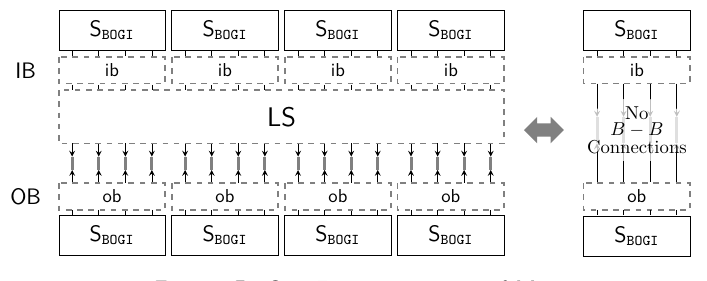
Figure 5: Our Decomposition of M